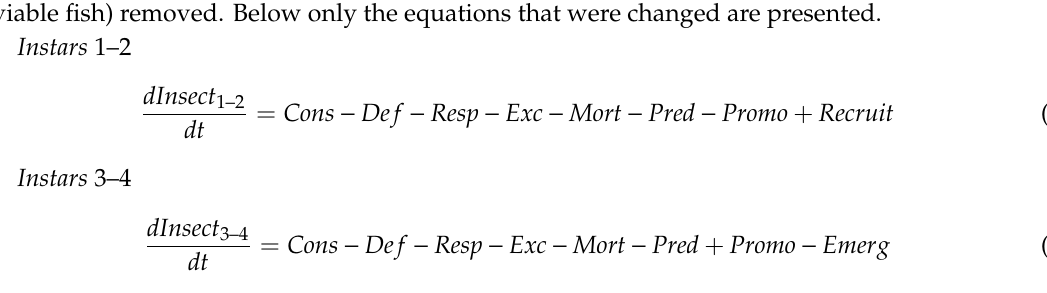
Figure 4. Conceptual model of the Chaoborus life cycle.